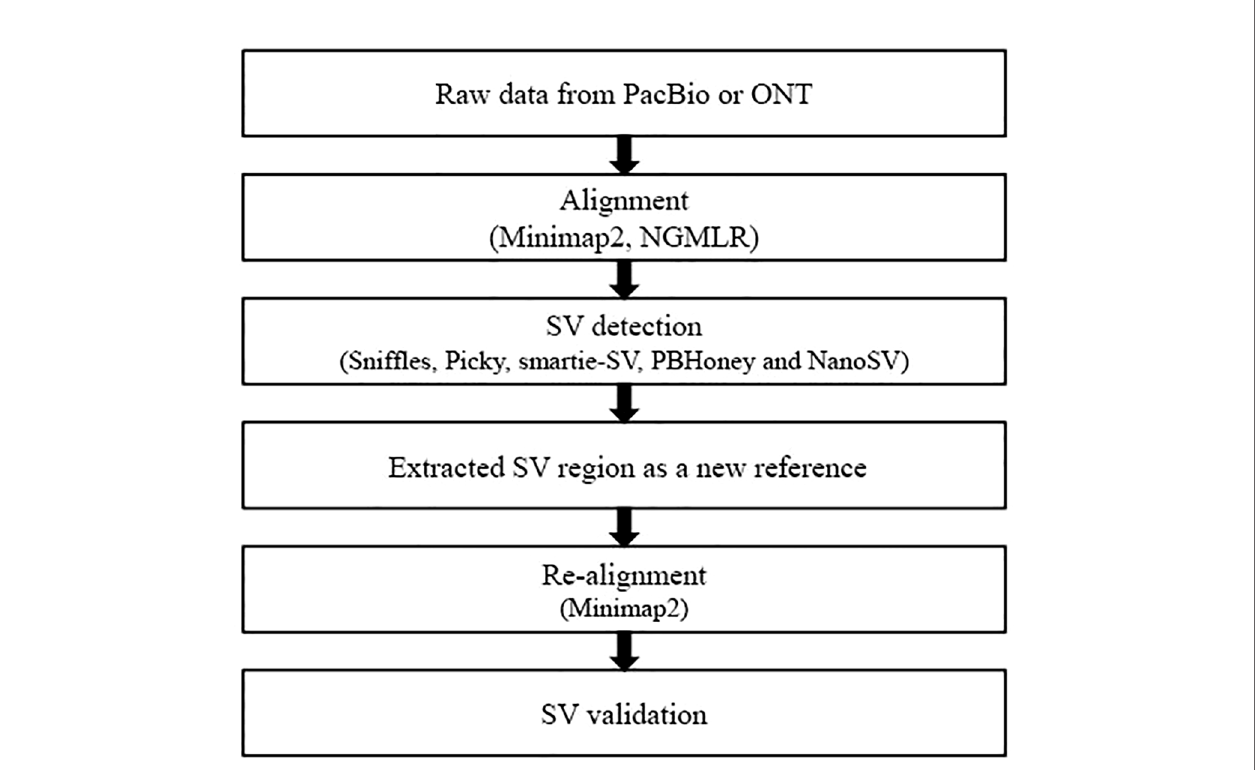
FIGURE 1 | Overview of the evaluation pipeline in this study. Minimap2 (Li, 2018) and NGMLR (Sedlazeck et al., 2018) were used to perform alignment. Minimap2 aligned against reference genome with parameters ‘– MD -x map-pb/map-ont -R “ @RG\tID:default\tSM : SAM ” -a ’ and NGMLR with the default parameters. SVs were identi fi ed by fi ve callers, including Snif fl es (Sedlazeck et al., 2018), Picky (Gong et al., 2018), smartie-sv (Kronenberg et al., 2018), PBHoney (English et al., 2014), and NanoSV (Cretu Stancu et al., 2017). Snif fl es detected all types of SVs with parameters ‘– genotype – skip_parameter_estimation – min_support 10 ’ and employed a novel SV scoring scheme to exclude false SVs based on the size, position, type, and coverage of the candidate SVs (Sedlazeck et al., 2018). NanoSV was set ‘ -s samtools ’ to detect SVs and used the clustering of split reads to identify SV breakpoint junctions based on long-read sequencing data (Cretu Stancu et al., 2017). PBHoney considered both intra-read discordance and soft-clipped tails of long read (>10, 000 bp) to identify SVs (English et al., 2014). PBHoney, smartie-sv, and Picky were used to identify SVs with default